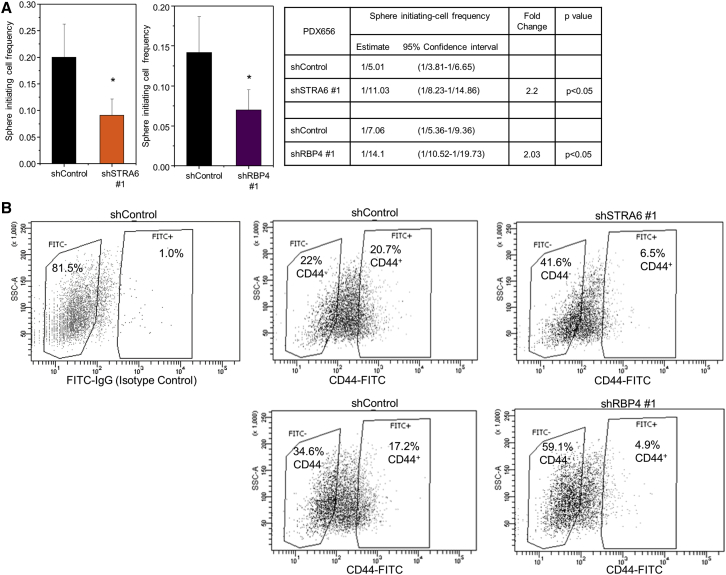
RBP4-STRA6 Pathway Maintains CSC Frequency in a PDX Model(A) Sphere-initiating cell frequency of PDX 656 cells stably transfected with control or STRA6 (left) or RBP4 (right) shRNAs. A representative frequency estimate calculated from 24 biological replicates of each cell dose is shown. Error bars represent 95% confidence intervals. ∗p < 0.05. Stem cell frequency estimates within confidence intervals and fold differences between control and designated lines are shown in the table on the far right.(B) Distribution of CD44-negative and -positive cells upon stable knockdown of STRA6 (top) or RBP4 (bottom) in PDX 656. FITC-immunoglobulin G (IgG) isotype control was used to set up the gates. Percentage of cells in each fraction is shown.